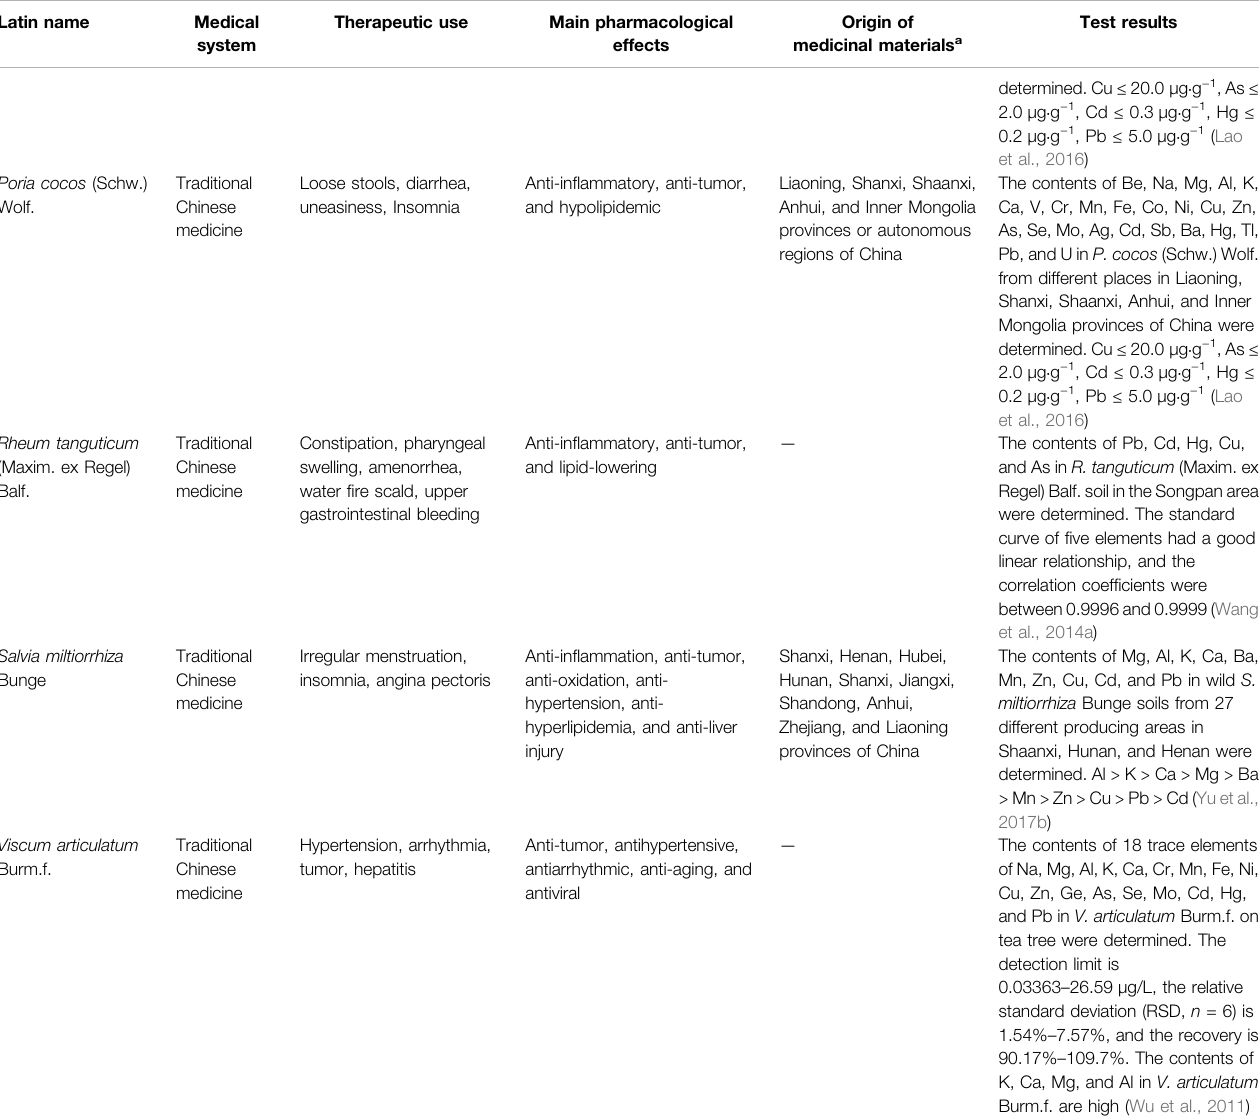
TABLE 7 | ( Continued ) Application of ICP-MS in the determination of heavy metal elements in other medicinal materials derived from plants and